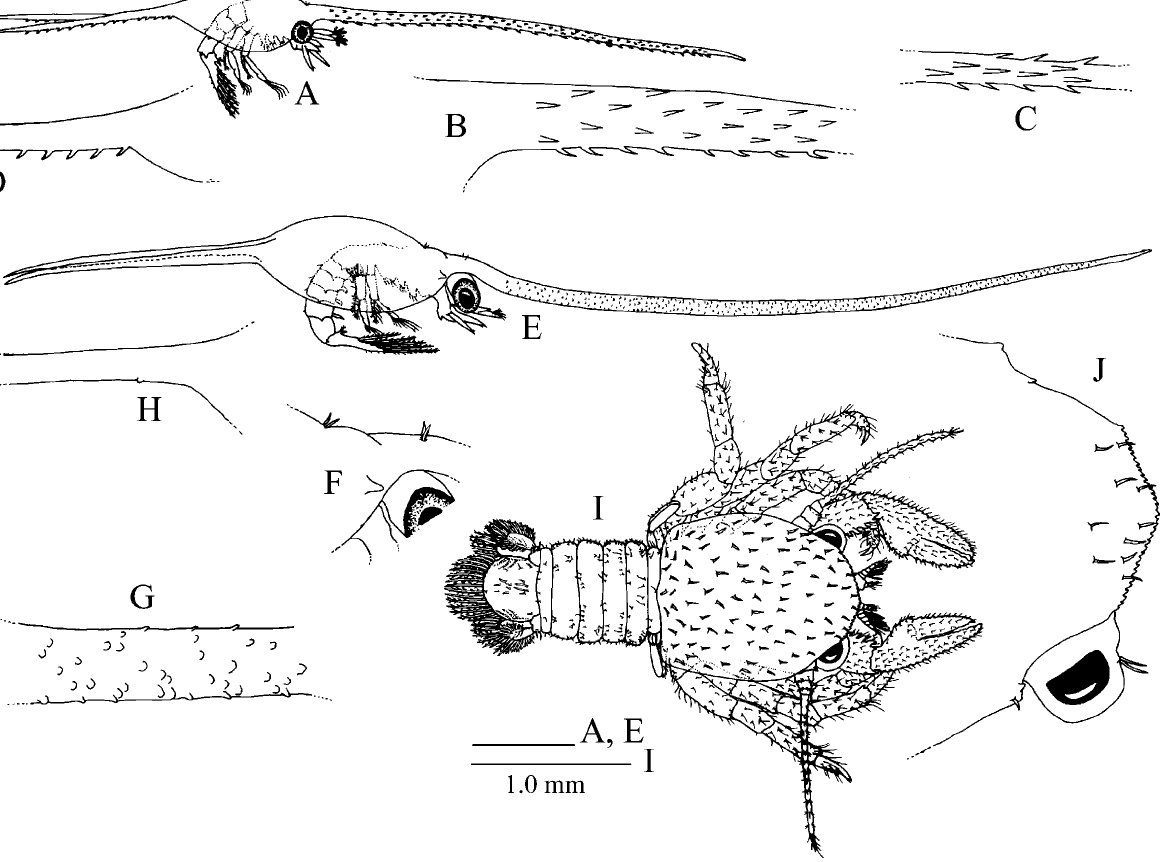
F IG . 1. – Clastotoechus nodosus. Lateral view of zoea I (A) and zoea II (E); proximal (B), and medial (C) portions of rostrum of zoea I; details of postorbital spine of zoea II (F); proximal portion of posterior spines of zoea I (D) and zoea II (H); medial portion of rostrum of zoea